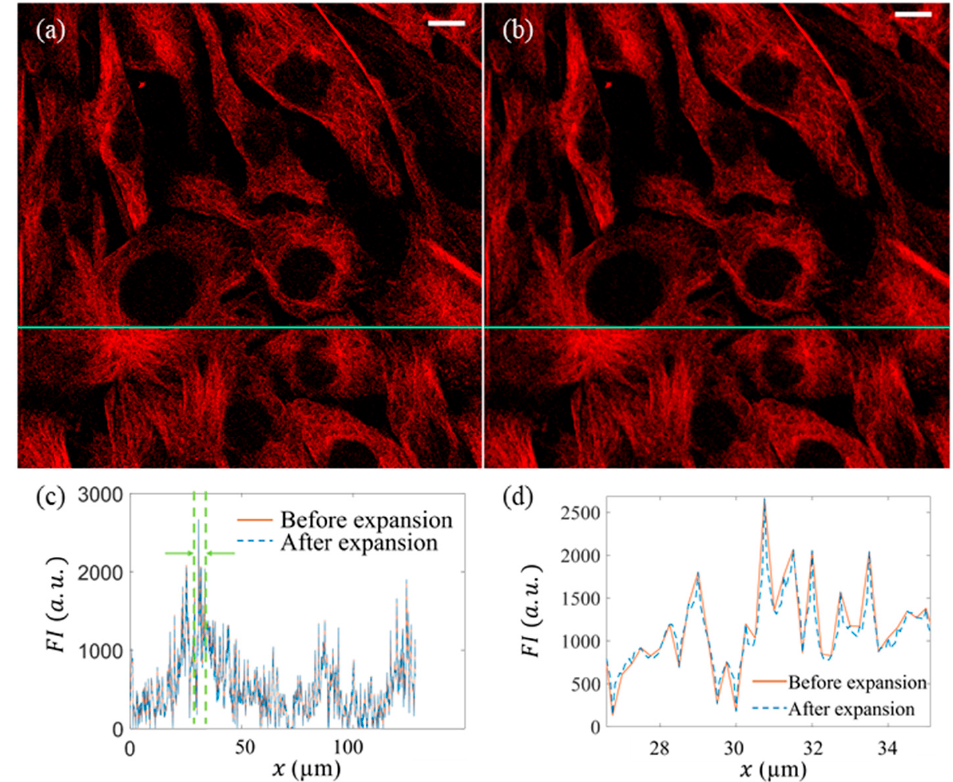
Figure 8. Comparison between the original and expanded images. White scale bars represent 10 µm. ( a ) Original image; ( b ) expanded image; ( c ) distributions of fluorescent intensity (NFI) on the corresponding horizontal and vertical positions before and after expansion; ( d ) zoom-in of ( c ).